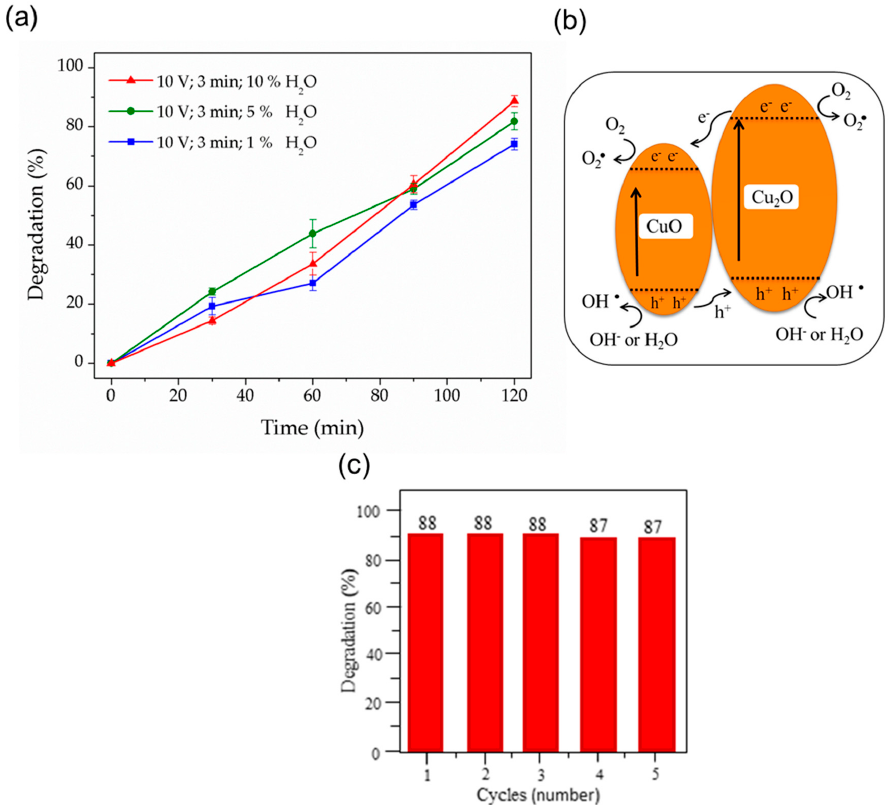
Figure 6. ( a ) Percentage of methylene blue (2.5 mM of MB with 0.001 g/15 mL of CuO/Cu 2 O nanoneedles) degradation as a function of illumination time for different copper oxides nanostructures. ( b ) photodegradation diagram of MB with CuO/Cu 2 O and ( c ) recycling histogram after five cycles of MB degradation.